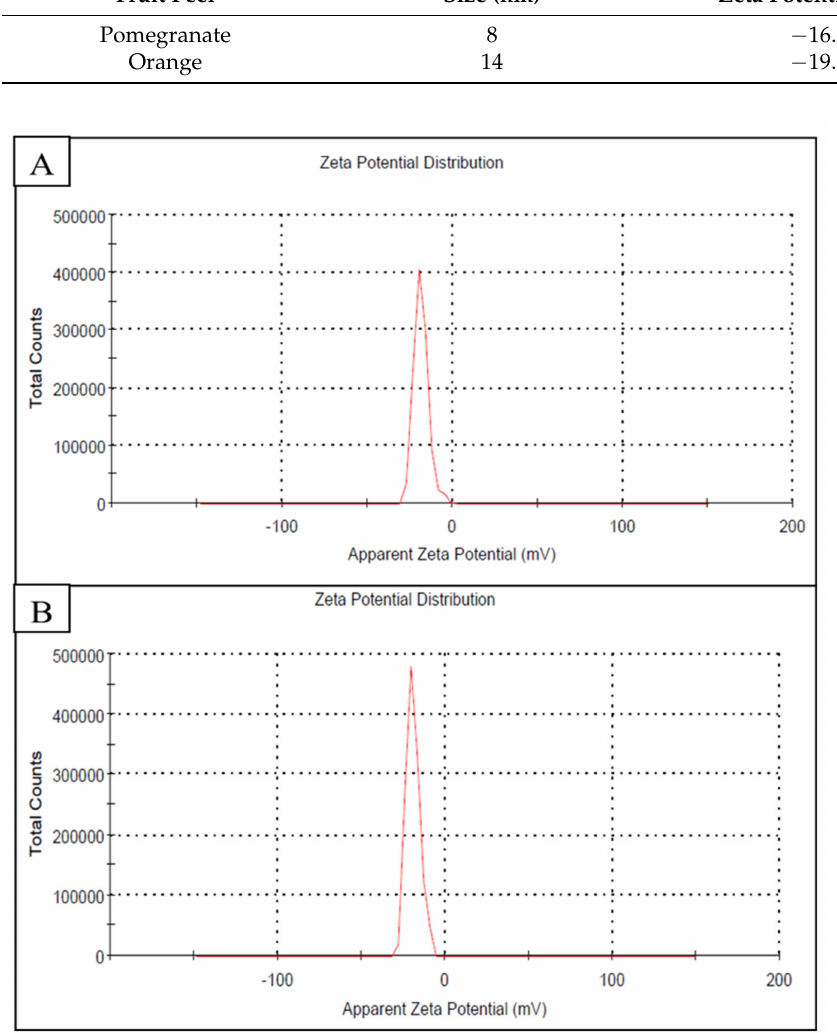
Figure 9. ( A ) Zeta potential of AgNPs synthesis by pomegranate peel showed − 16.9 mV. ( B ) Zeta potential of AgNPs synthesis by orange peel showed − 19.5